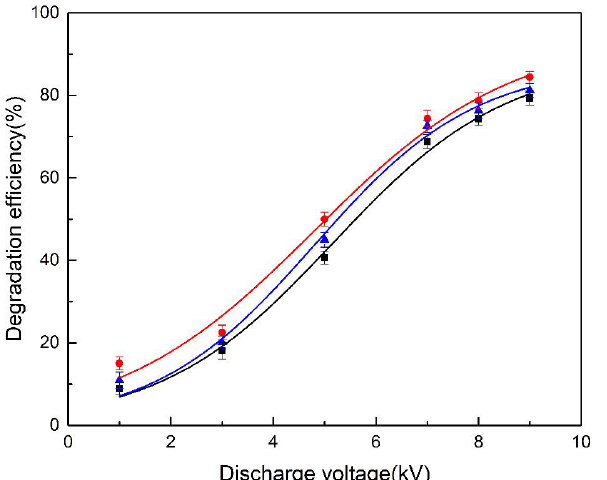
Figure 6. Effect of discharge voltage on chlorobenzene degradation (● 300 mg·m −3 , ▲ 600 mg·m −3 , ■ 1000 mg·m −3 ) (HRT = 5.5 s, oxygen concentration = 10%, chlorobenzene inlet concentration = 300 mg·m −3 , 600 mg·m −3 and 1000 mg·m −3 ).